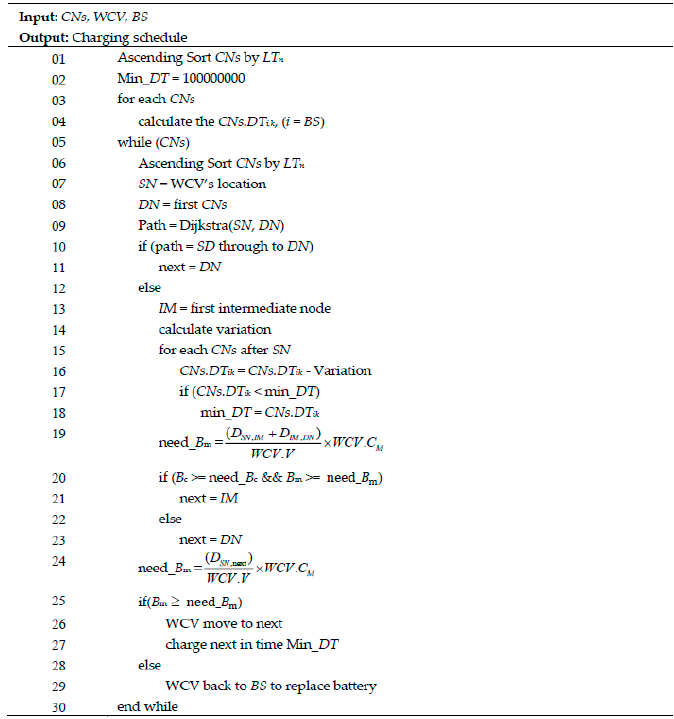
Figure 6. Delay ‐ based module algorithm. Figure 6. Delay-based module